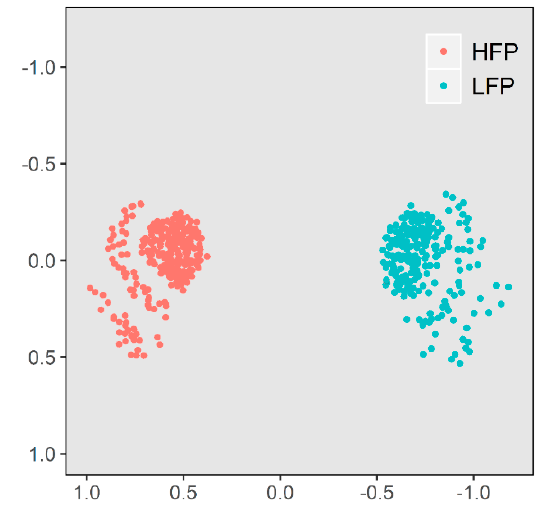
Figure 1. Multidimensional scaling of the high (HFP, n = 272) and low (LFP, n = 222) feather pecking lines. The distance to each other visualize their genetic distance.